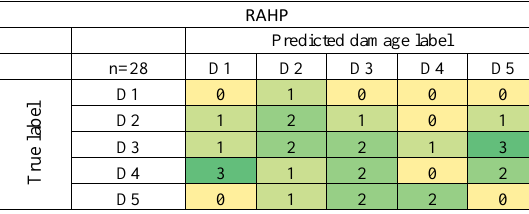
Figure 7. Confusion matrix for Revised Analytic Hierarchy Process